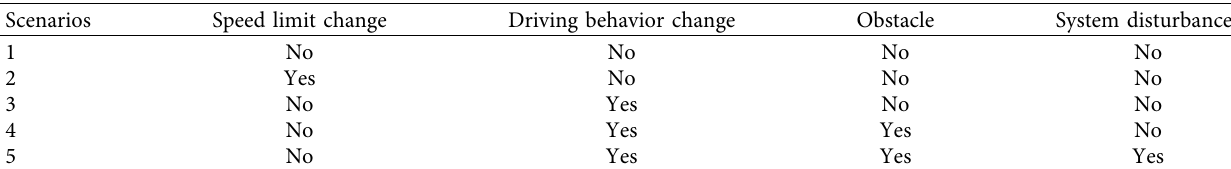
Table 3: Scenarios